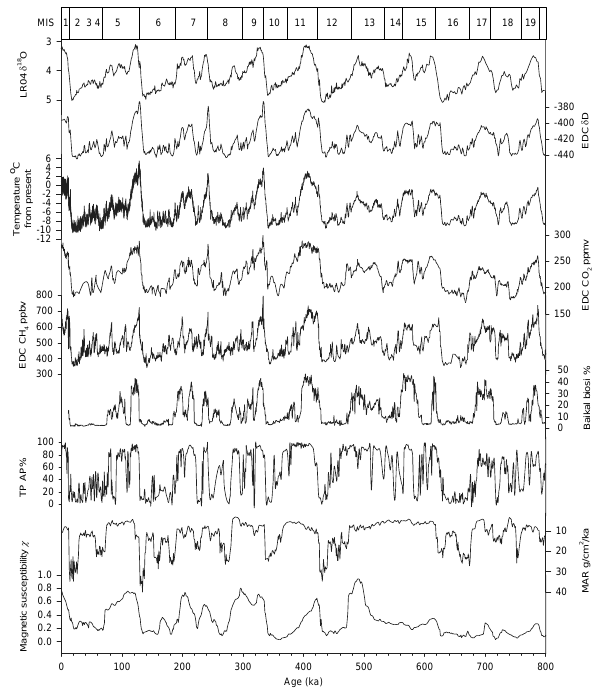
Fig. 2d. EPICA Dome C records on EDC3 timescale, and terrestrial records (on individual timescales); LR04 benthic stack and corre- sponding marine isotope stages (MIS) from